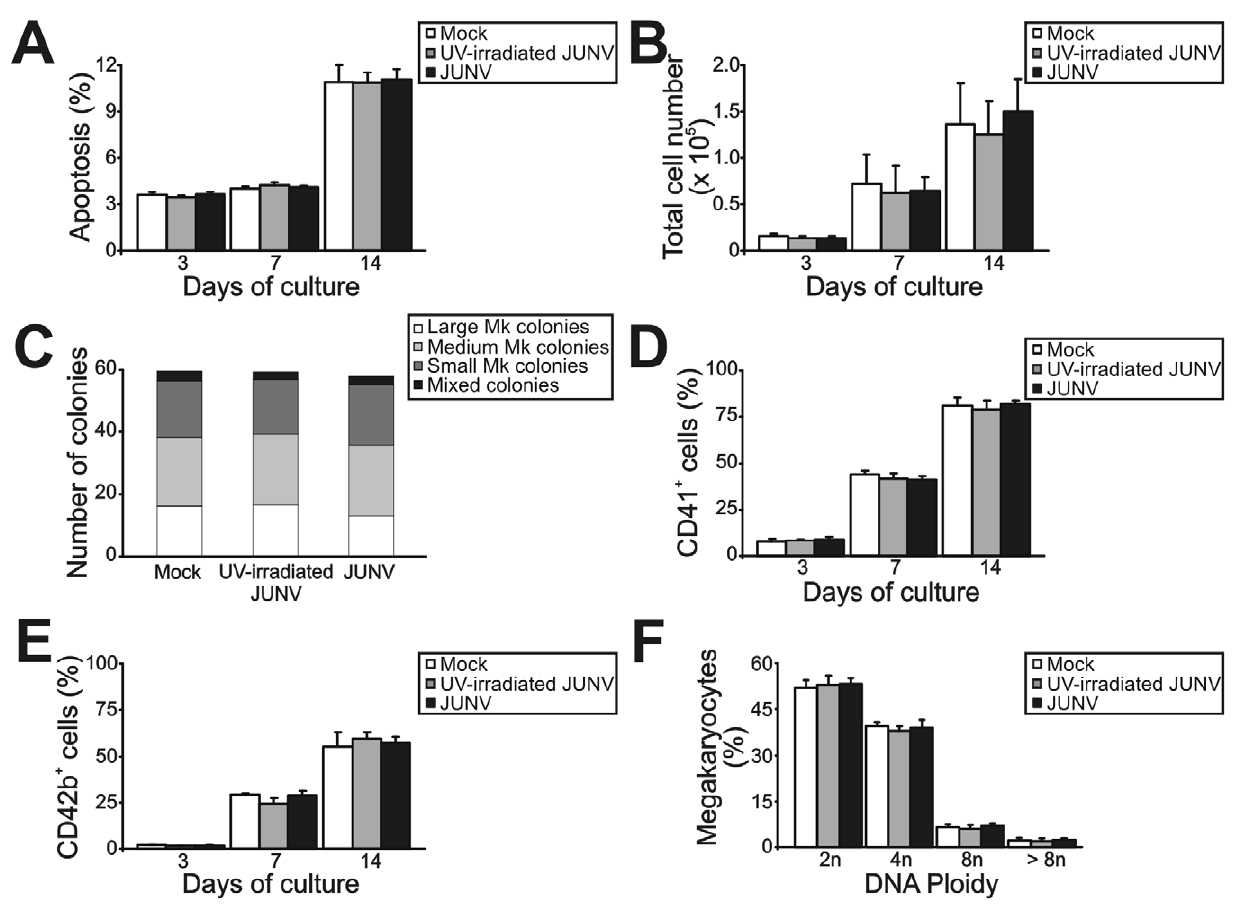
Figure 2. Influence of JUNV infection on cellular apoptosis, proliferation, clonogenic capacity and megakaryocyte development of TPO-stimulated CD34 + cells. CD34 + cells were infected with JUNV at a MOI of one or the equivalent volume of UV-irradiated virus or Vero cell supernatant (mock) for one hr at 37 u C, washed, and then stimulated with TPO. (A) Apoptosis, (B) total cell count, (C) megakaryocyte colonies grown in collagen-based serum-free medium containing 50 ng/ml TPO, percentages of (D) CD41 + and (E) CD42b + cells and (F) ploidy distribution were determined at the indicated days of culture, except for colonies and ploidy, which were counted after 12 or 14 days of culture, respectively. The values represent the mean 6 SEM of four independent